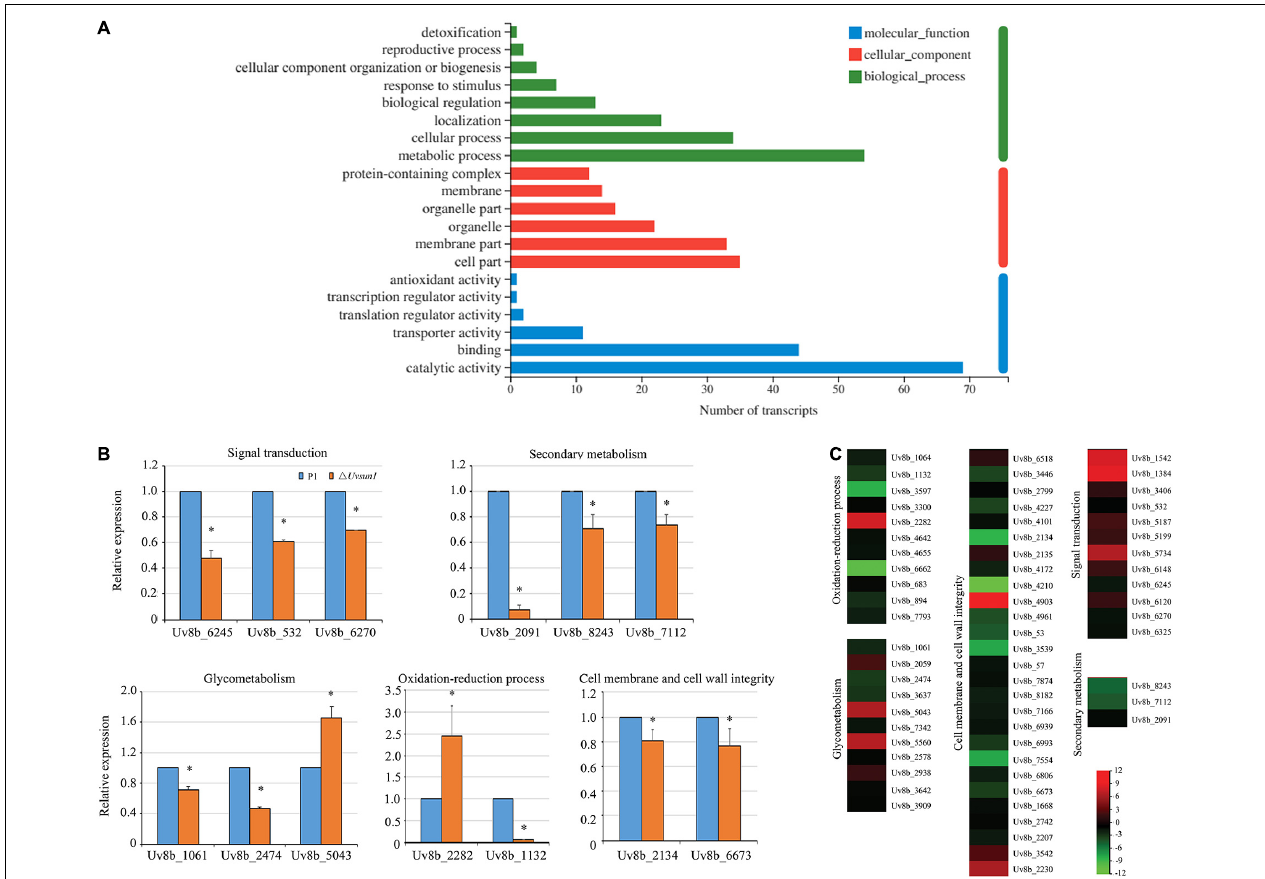
FIGURE 7 | Uvsun1 regulates the expression of a subset of genes. (A) Gene ontology (GO) analysis of significantly differentially expressed genes in (cid:77) Uvsun1 mutant compared with WT. The X -axis indicates the number of transcripts for each GO item on the Y -axis. (B) qRT-PCR analysis of Uvsun1 affected genes. Relative expression levels were normalized with β -tubulin as the internal standard. The presented as means ± SD from three biological replicates. Asterisks indicate significant differences (one-way ANOVA, ∗ p < 0.05). (C) Differentially expressed genes in the (cid:77) Uvsun1 mutants might indicate involvement in pathogenesis and development. Regulated genes include genes involved in signal transduction, secondary metabolism, glycometabolism, oxidation-reduction process and cell membrane and cell wall integrity. The biological functions of the genes are shown in Table 2